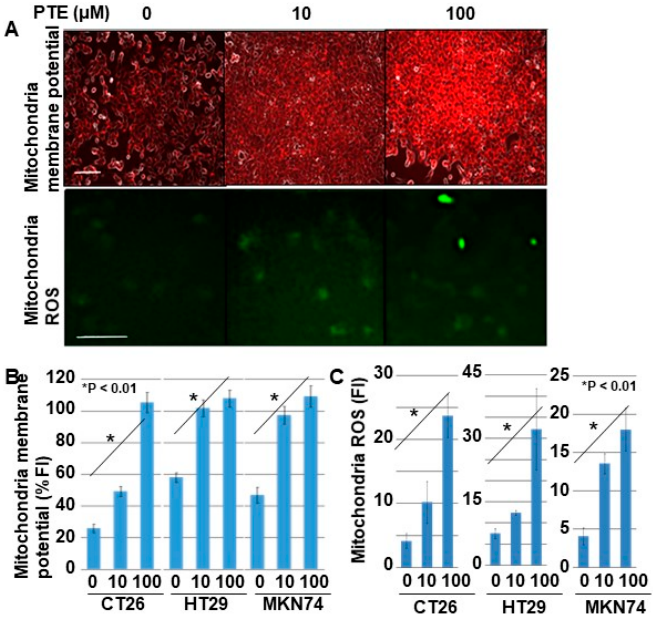
Figure 4. Effect of PTE on mitochondrial function in cancer cells. Mitochondrial membrane voltage and mitochondrial reactive oxidative species (ROS) were examined by tetramethyl rhodamine (TMRE) and dihydrorhodamine (DHR), respectively. Cells were treated with PTE for 48 h. ( A ) Fluorescence images of TMRE and DHR. TMRE image was merged with phase-contrasted image. Scale bar, 25 μ m. ( B , C ) Semi-quantification of mitochondrial membrane potential (TMRE) and mitochondrial ROS (DHR), respectively. Error bar, standard deviation from three independent examinations. Statistical difference was calculated by ordinary analysis of variance. PTE, pterostilbene; TMRE, tetramethyl rhodamine; ROS, reactive oxidative species; DHR, dihydrorhodamine 123; FI, fluorescence intensity.